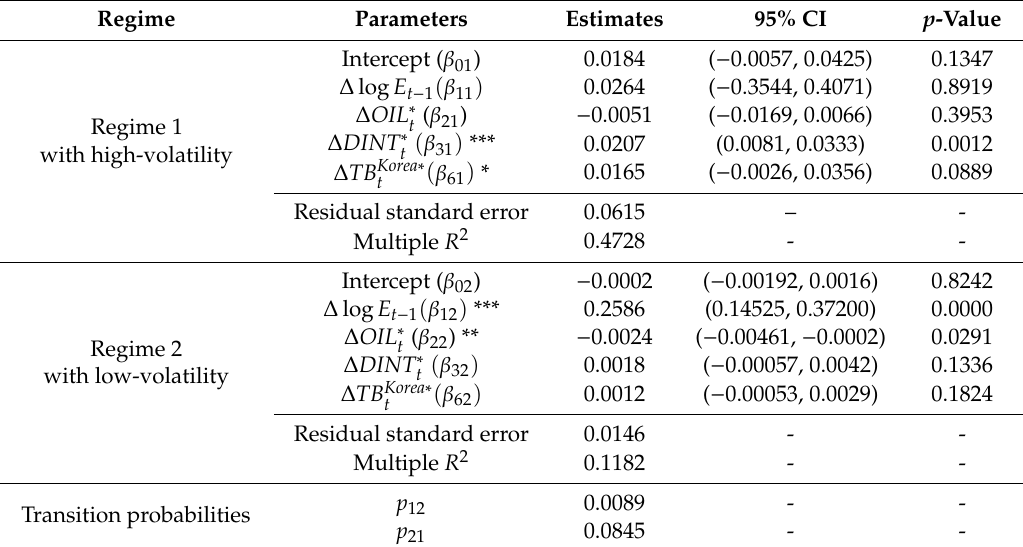
Table 3. Parameter Estimates of the Selected MRSM in